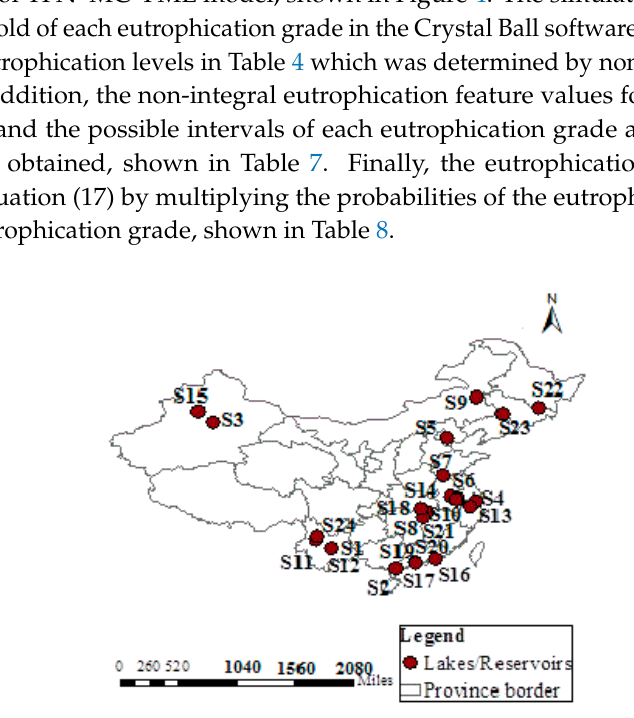
Figure 3. Locations of 24 typical lakes/reservoirs in China.